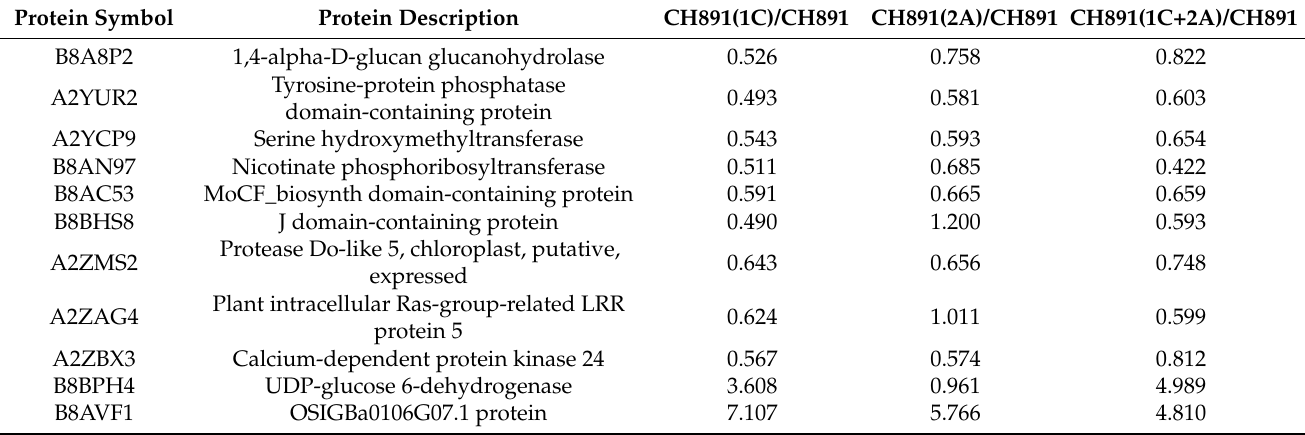
Table 2. Functional classification of key differential proteins in